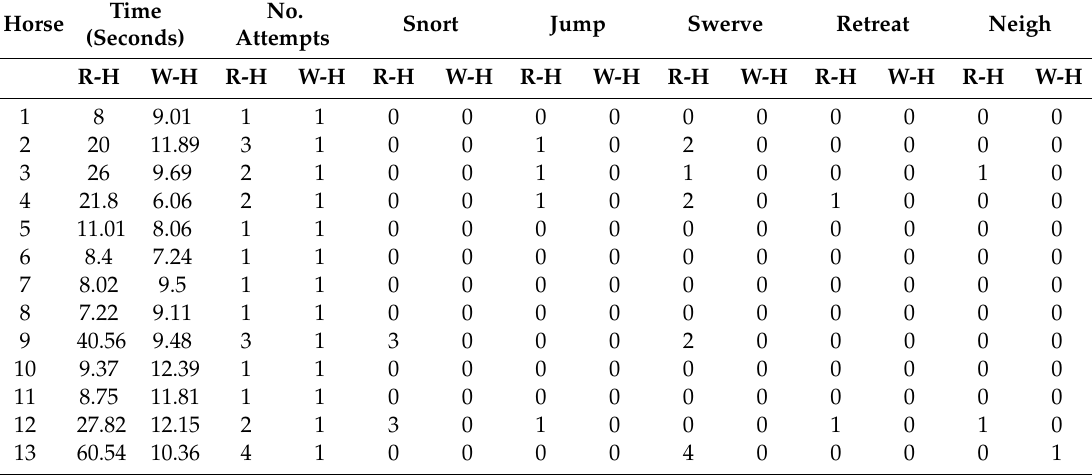
Table 2. Exact time required for the bridge test, number of attempts, and frequency of occurrence of each behavioral event registered for each horse. Mean and standard deviation (SD) of each variable are also